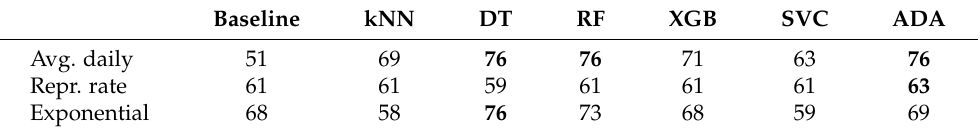
Table 11. The accuracy (%) achieved for different ML algorithms with hyper-parameter tuning and all features. The experiment was repeated for each class, and the highest accuracy is shown in bold.